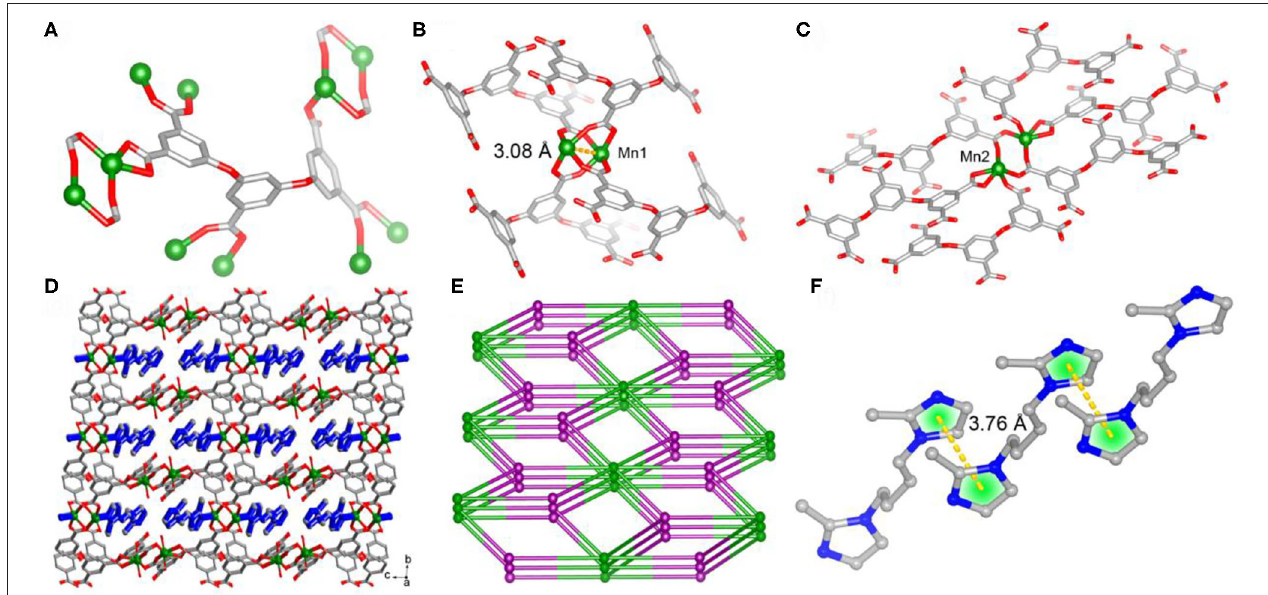
FIGURE 1 | The coordination modes of L ligand (A) and binuclear Mn(II) clusters (B) and (C) in 1 . (D) View of the 3D network of 1 with protonated BMIB ligands fixed in the channels through coordination bonds. (E) Schematic illustration of 3D network of 1 . (F) π -stacking between BMIB ligands.